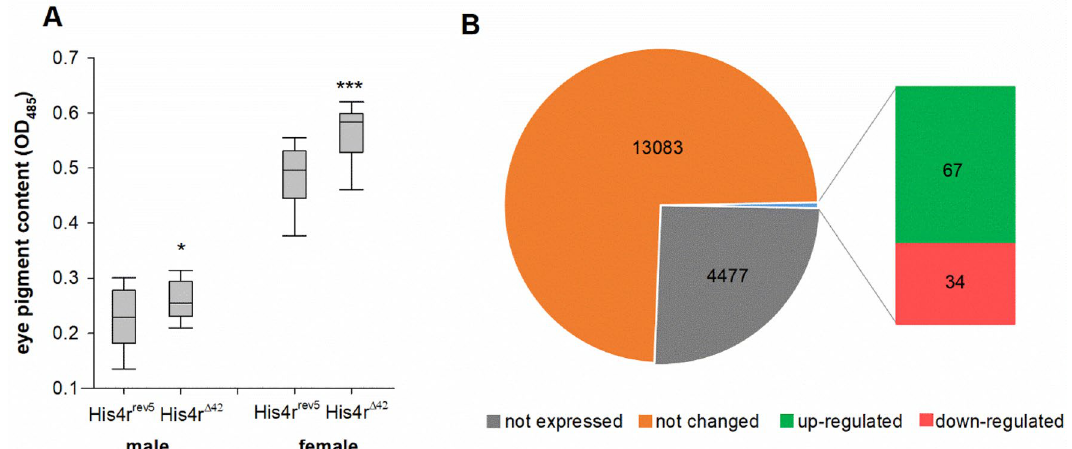
Figure 4. Loss of His4r has mild effect on PEV and transcription. (A) Heterozygous loss of His4r results in mild but significant suppression of position-effect variegation of w m4h in both genders. Boxplot shows the distribution (first quartile, median, third quartile, and 10th and 90th percentiles as whiskers) of eye pigment absorbance values measured at 485 nm. *P < 0.05, ***P < 10 −3 (t-test, n = 20). (B) Loss of His4r has a modest effect on transcriptional activity. Out of the 13,184 genes that were transcriptionally active (FPKM ≥ 1) in males only 101 showed altered expression levels in His4r Δ42 homozygotes compared to His4r rev5 controls: 67 were up- while 34 were